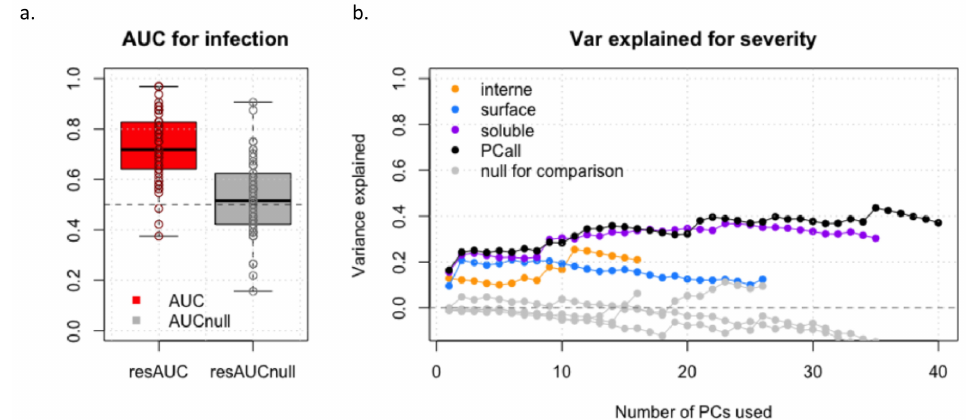
Figure 3. Prediction accuracy of fetal infection ( a ) and of severity ( b